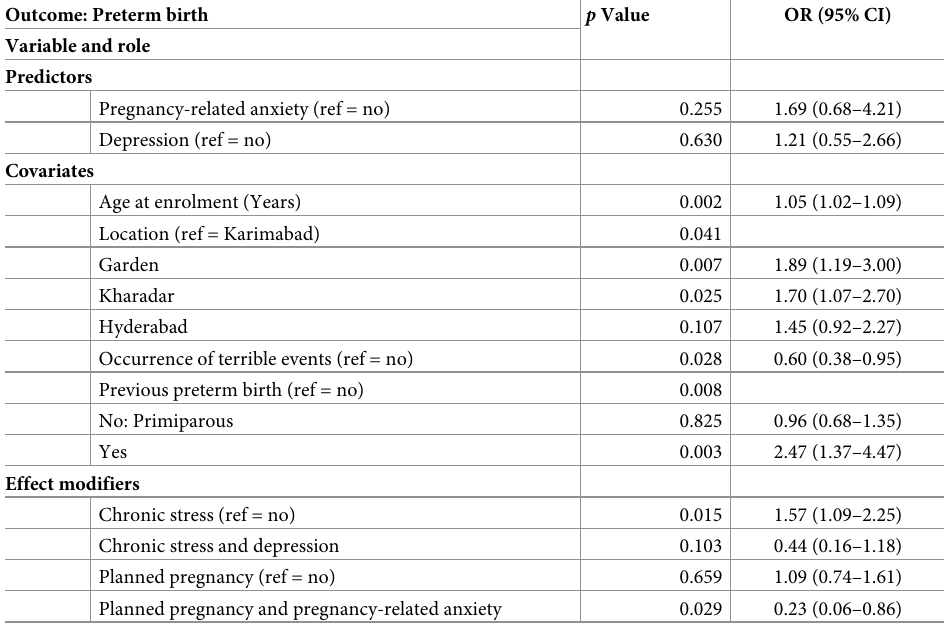
Table 3. Final model for preterm birth given antenatal psychosocial distress conditions at time